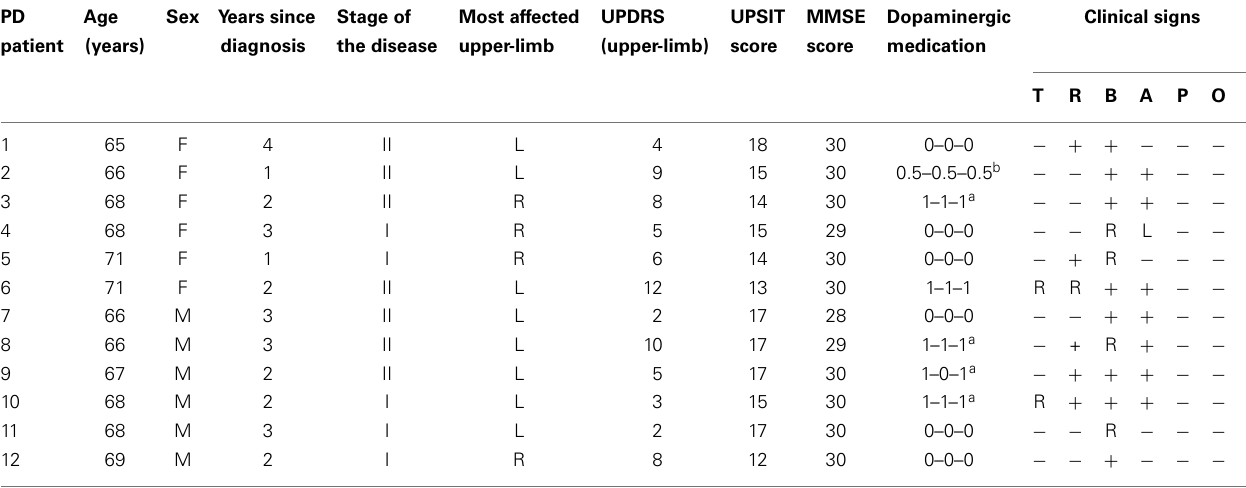
Table 2 | Demographic data and clinical features of the patients with idiopathic Parkinson’s disease (IPD) studied .